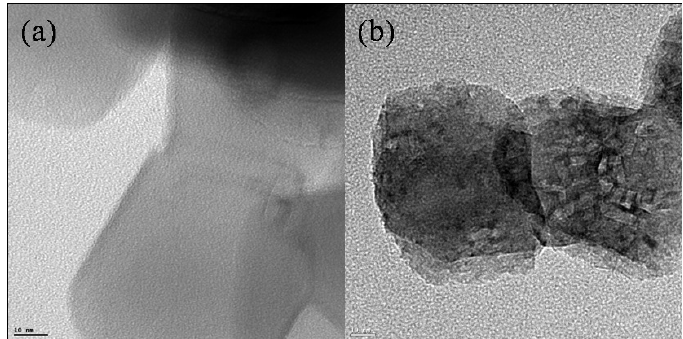
Figure 6. Surface morphology change of calcite.TEM images of (a) raw calcite surface and (b) dissolved calcite surface in 0.02 M L -glu solution for 4 hours.